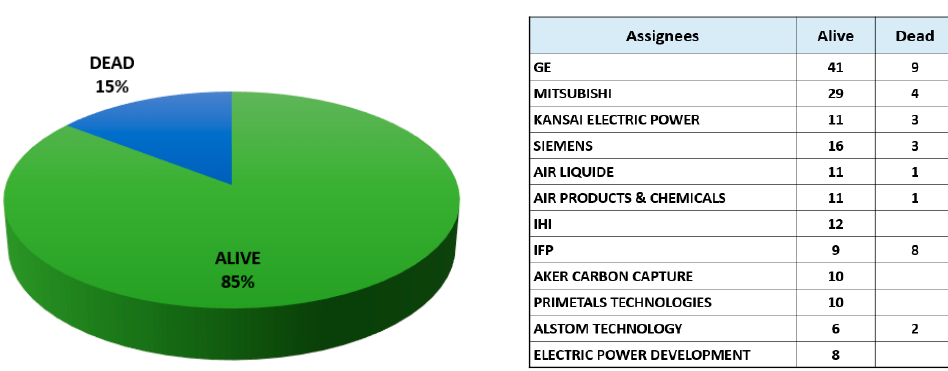
Figure 9. Legal status of the patent families.